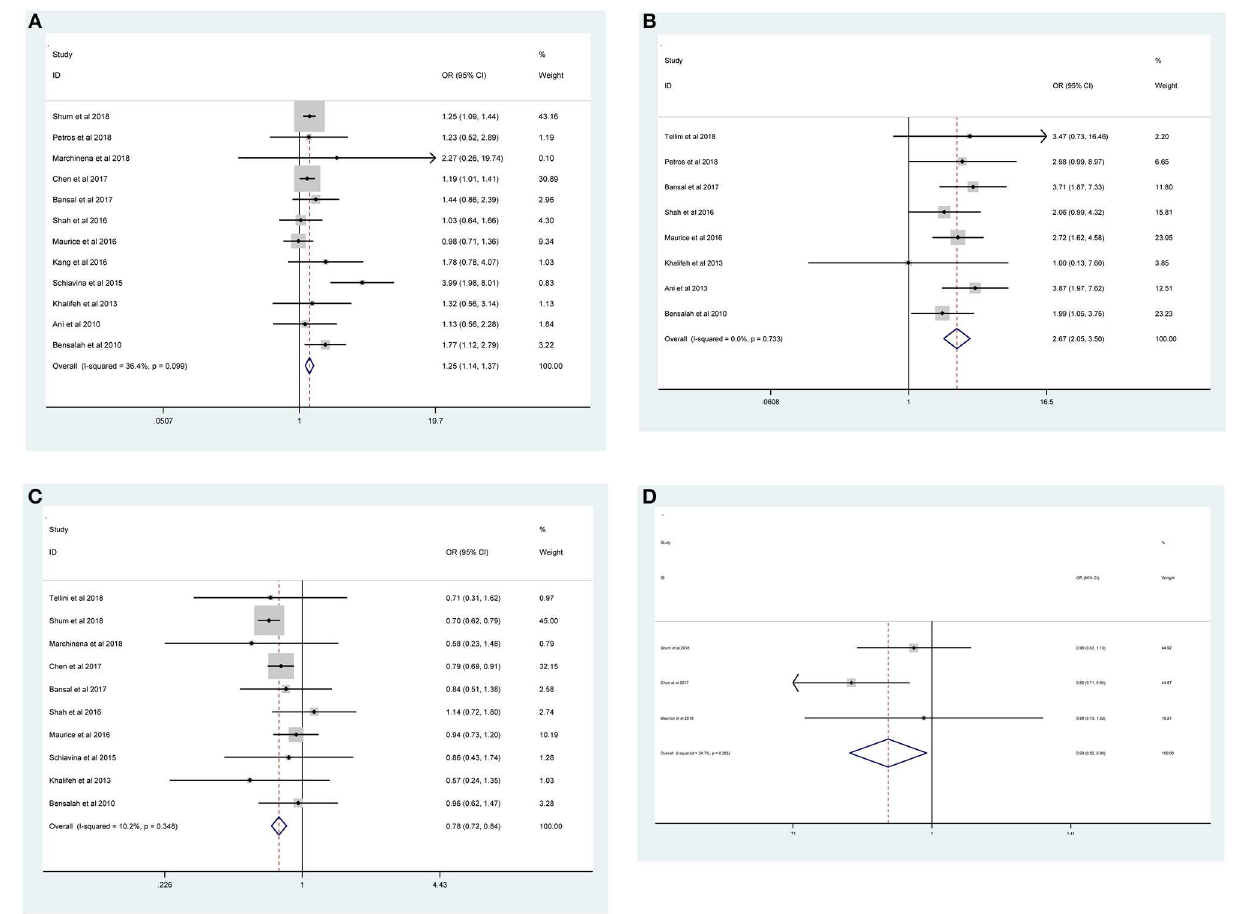
Frontiers in Oncology |